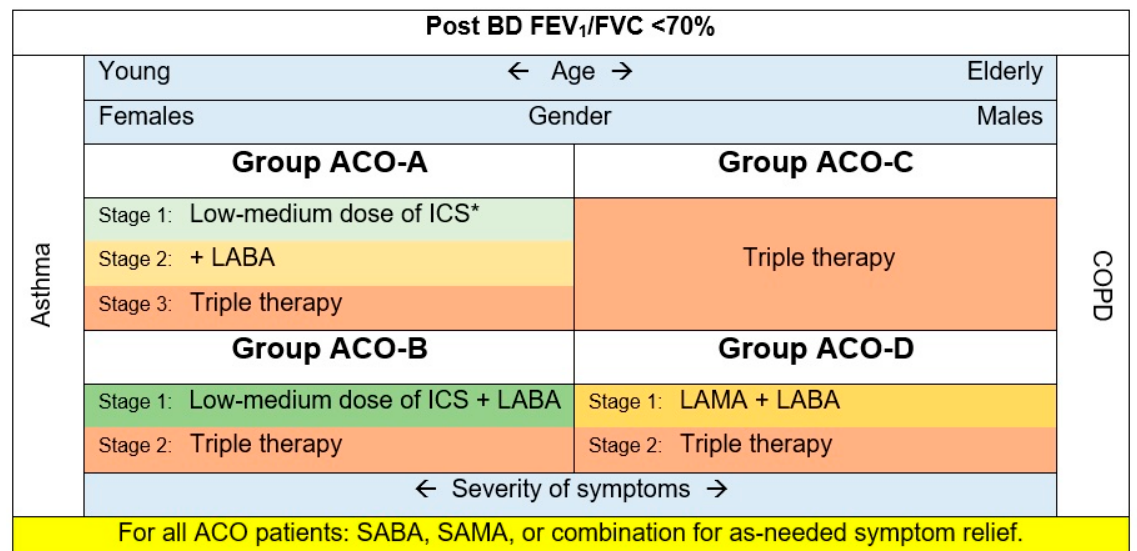
Figure 1. The treatment scheme for ACO patients based on the four phenotypes. * This stage can be skipped for patients with frequent exacerbations.